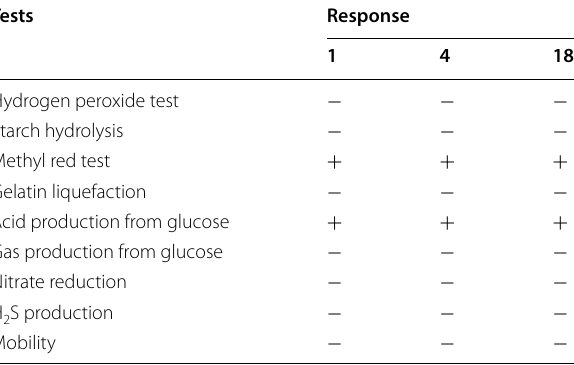
“ ” is positive and “ +